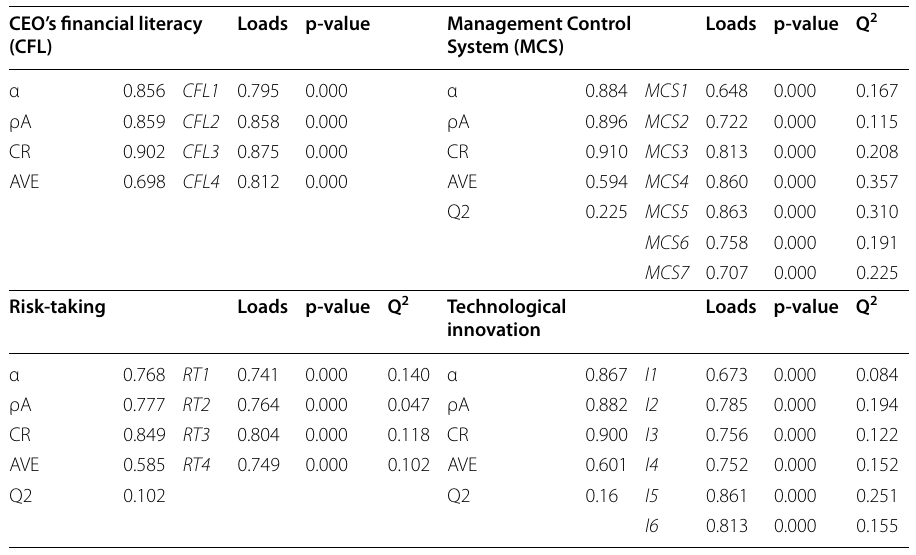
Convergent validity and